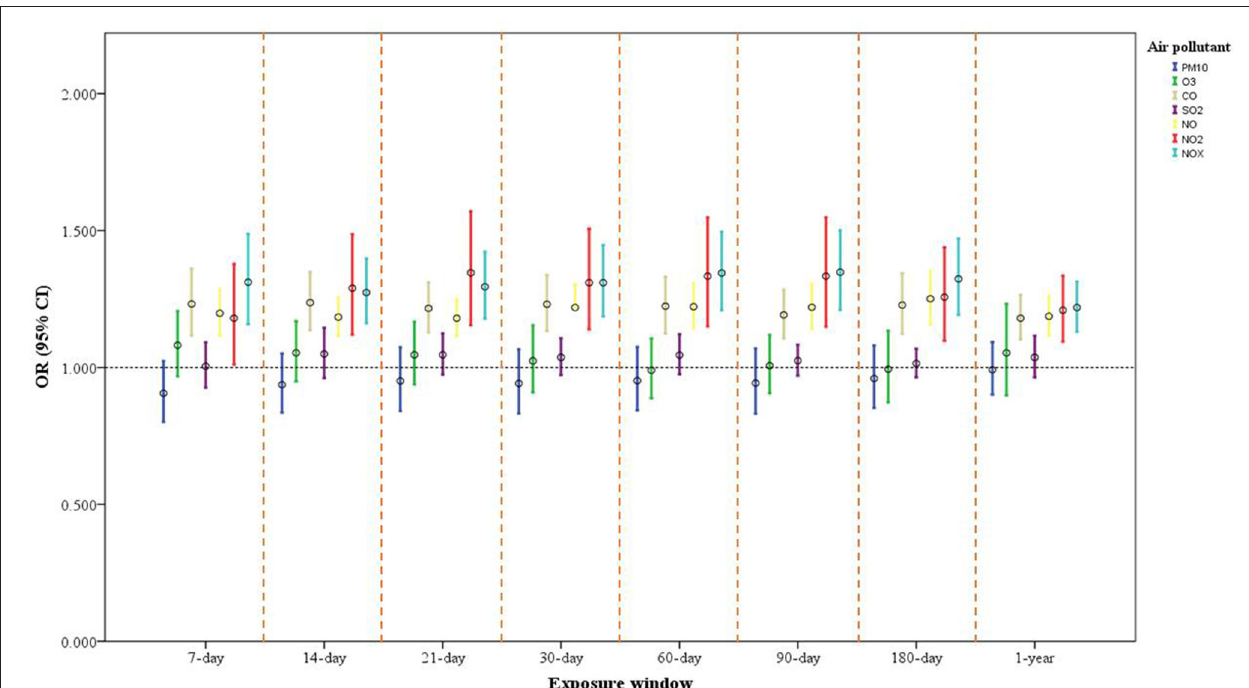
FIGURE 2 | One-pollutant model of air pollution exposure and its association with depressive symptoms in older adults. Model adjusted for sex, age, marital status, educational attainment, financial status (self-reported), physical activity, alcohol intake, heart disease, IADL score, season of study visit, and SPMSQ score. The ORs and 95% CIs for each increase of interquartile range (IQR) in PM 10 , O 3 , CO, SO 2 , NO, NO 2 , and NOx are